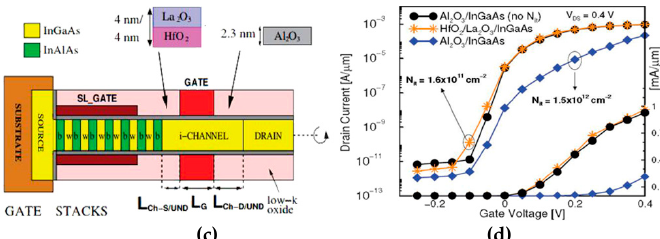
Figure 18. ( a ) Transfer characteristics and ( b ) I on , I off , g m and I on /I off ratio of InAs nanowire gate-all-around transistors with different gate dielectrics [151]. ( c ) Device structure and ( d ) transfer characteristics of InGaAs/InAlAs nanowire superlattice-FET’s with Al 2 O 3 and HfO 2 /La 2 O 3 gate dielectrics [152] .